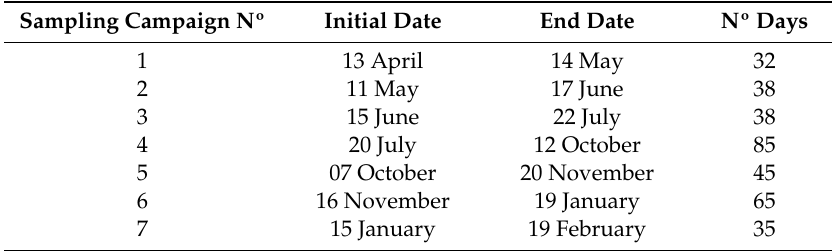
Table 1. Identification of the sampling points (SP) and the influence of possible emission sources.